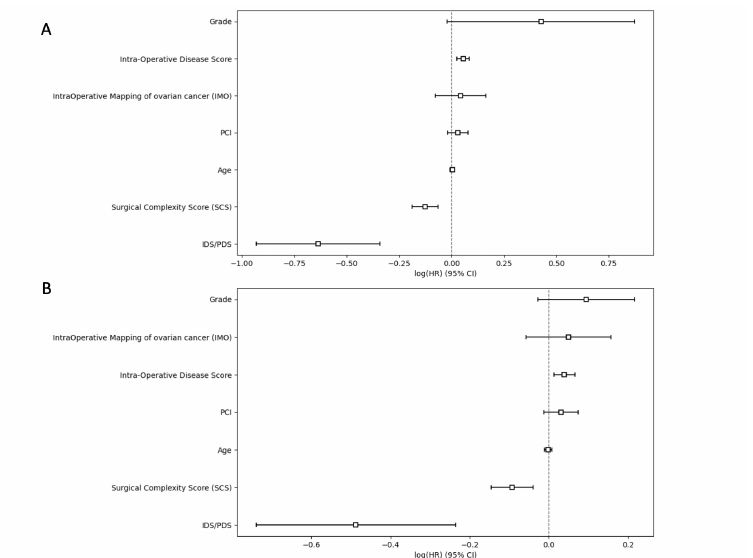
Figure A3. Hazard ratio (HR) and 95% confidence interval (CI) for prospective log-linear associa- tions (Cox regression) between ( A ) recurrence and non-recurrence ( B ) fatal and non-fatal outcomes including the variables estimated from the multilevel modeling framework. The novel score is a better prognosticator of PFS than the IMO and PCI scores. The IMO score better predicts OS than the new score, but that was not